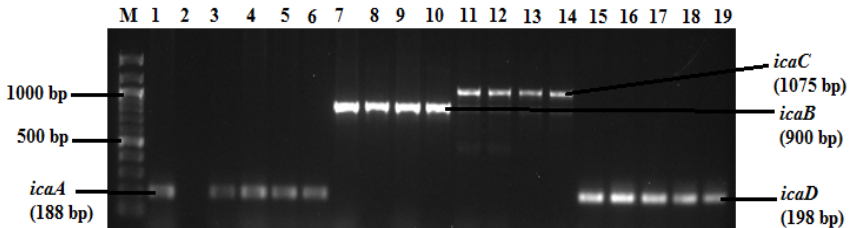
Table 1. Distribution of biofilm formation with respect to study